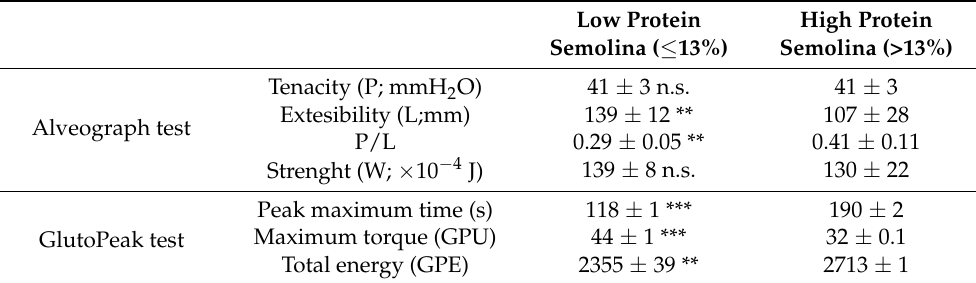
Table 1. Indices obtained by the Alveograph and Glutopeak tests.